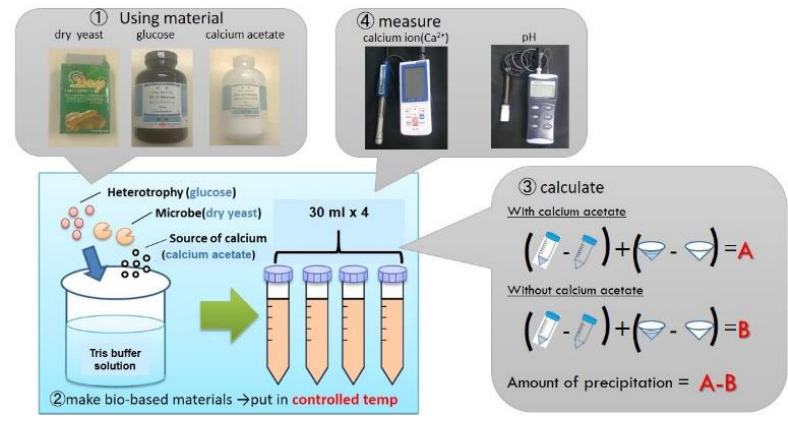
Figure 2. Scheme of mixtures and measurement.